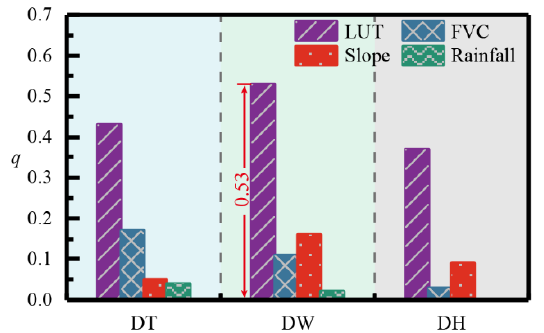
Figure 6. The q values of four factors in the three dry valley subtypes (DT: dry–temperate valley, DW: dry–warm valley, and DH: dry–hot valley).